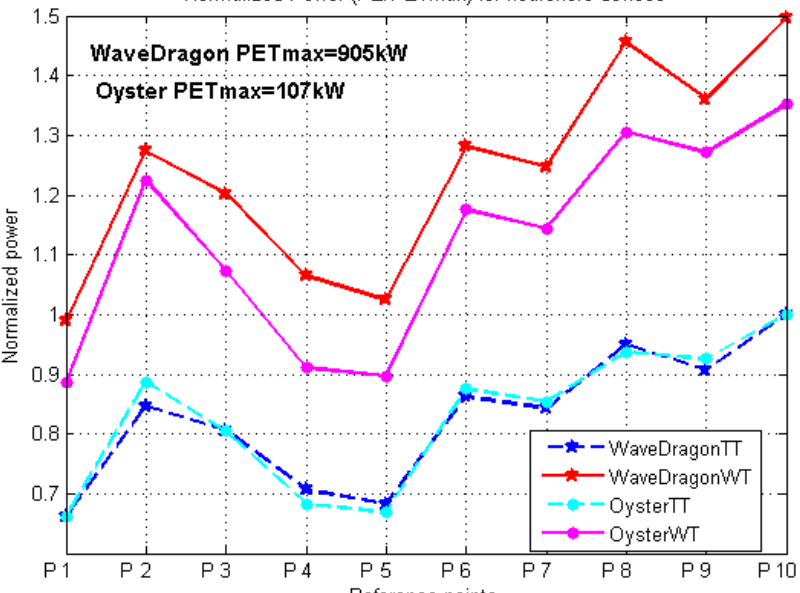
Figure 7. Normalized electric power for the nearshore devices in the reference points (from north to south) corresponding to total (TT) and winter time (WT),